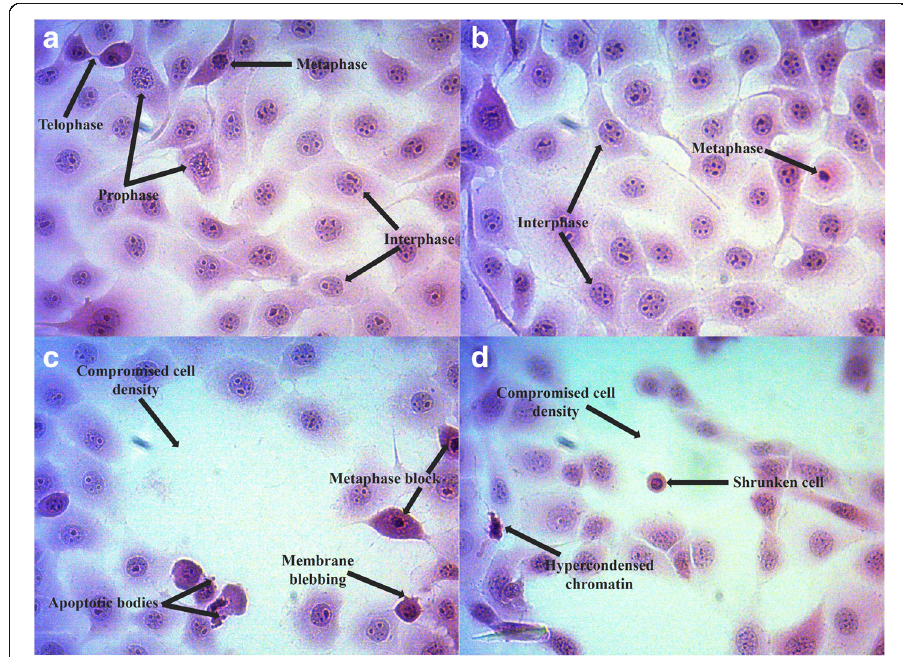
Fig. 4 Light microscopy images revealing the morphological effects of ESE-16 on the nuclear and cytoplasmic structures in HeLa cells. a and b Cells propagated in growth medium ( a ) and vehicle-treated control cells ( b ) showed a dense population and normal division. Most cells were found to be in interphase. c and d Cells exposed to ESE-16 ( c ) and 0.1 μ g/ml actinomycin D ( d ) revealed membrane blebbing, apoptotic bodies